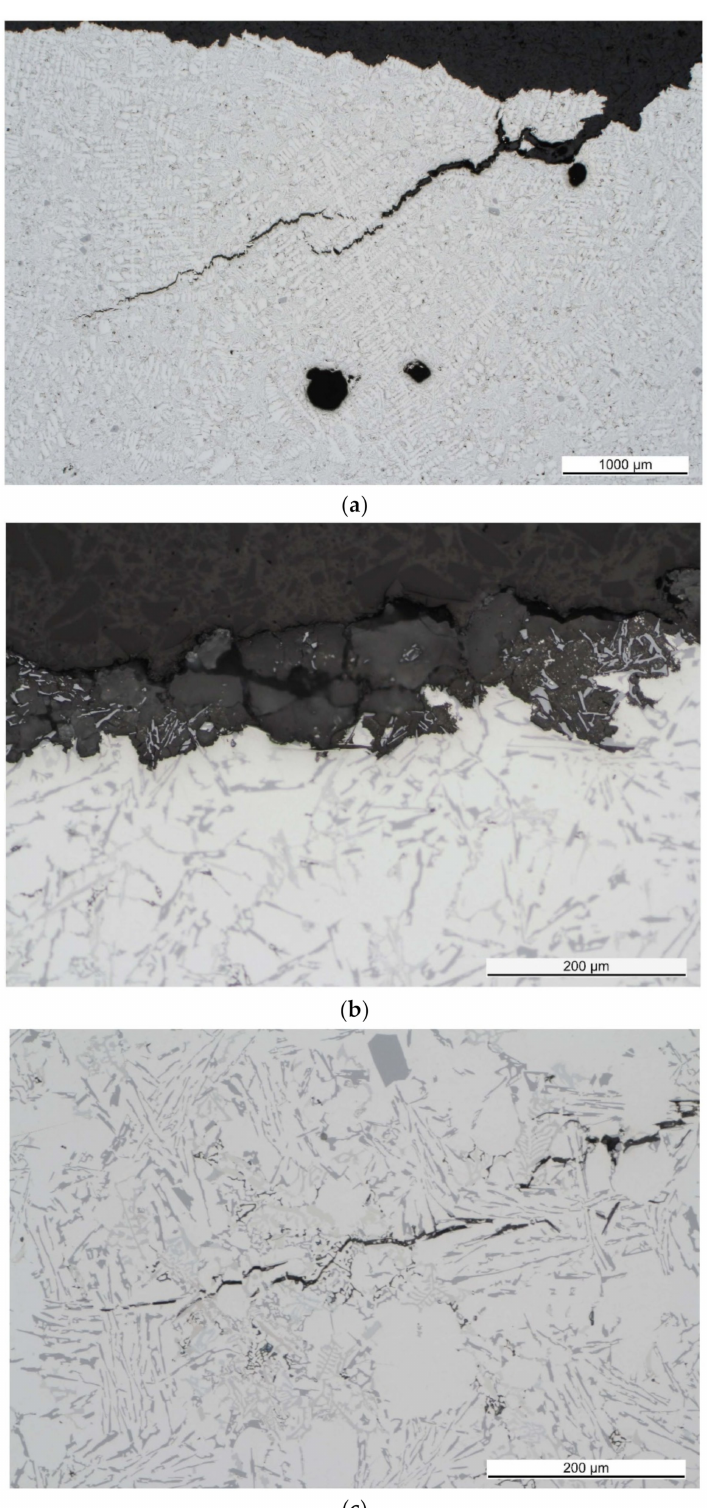
Figure 4. Micrographic section: ( a ) overview with corroded fracture surface, a secondary crack, and pores; ( b ) corroded fracture surface, showing local corrosion pits; and ( c ) secondary crack along the interdendritic Al–Si